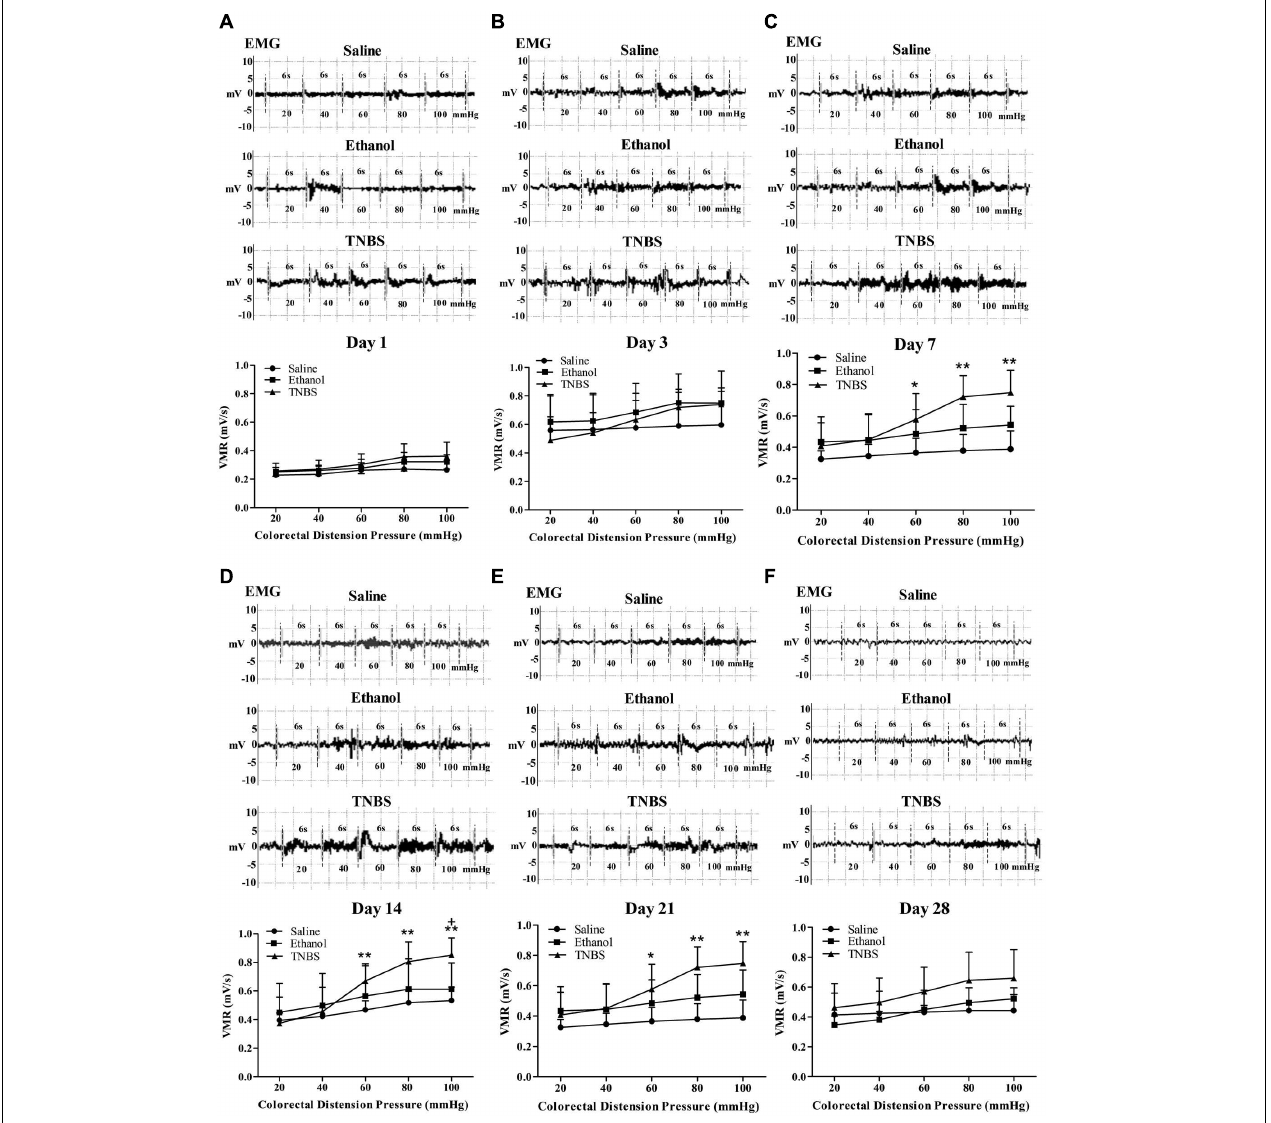
FIGURE 6 | Effects of TNBS administration on VH, measured by EMG of abdominal muscles’ VMR to CRD pressure. Representative EMG traces and VMR to CRD at day 1 (A) , 3 (B) , 7 (C) , 14 (D) , 21 (E) , and 28 (F) . ∗∗ P < 0.01, ∗ P < 0.05; TNBS group/Ethanol group vs. Saline group. + P < 0.05; TNBS group vs. Ethanol group. Kruskal–Wallis analysis followed by Mann–Whitney U